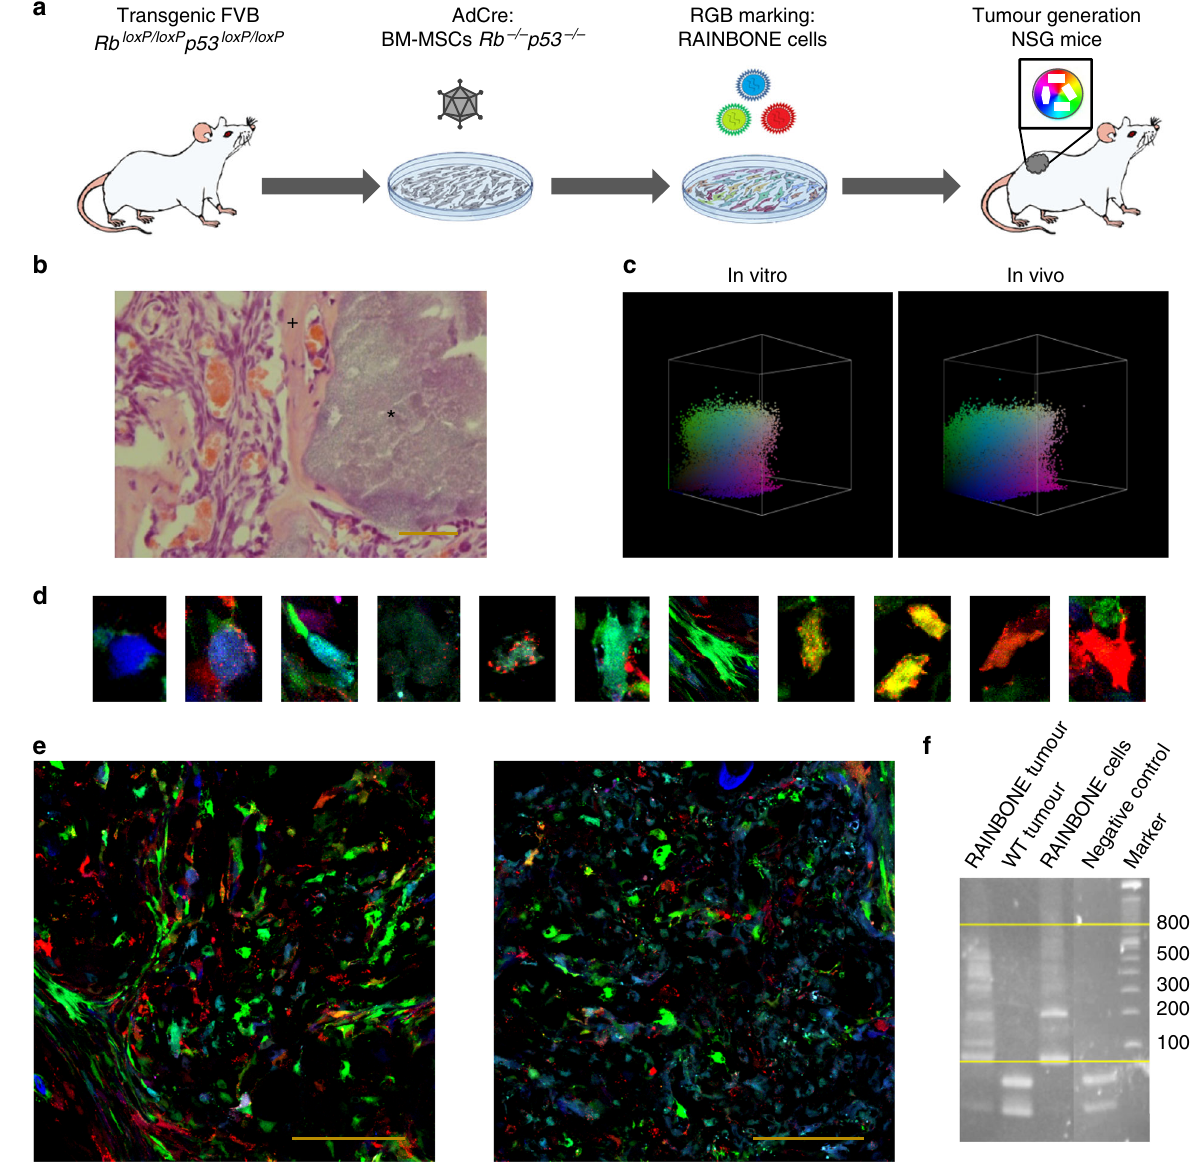
Fig. 2 RAINBONE cells generate polyclonal tumours in ectopic implants. a Experimental scheme employed for ectopic OS development ( n = 7). b Haematoxylin/eosin staining (HE) staining of tumours generated by ectopically implanted cells. Spindled cells produced abundant bone matrix ( + ) near HA/TCP ceramics (*). c Representative 3D fl ow cytometry analysis of in vitro RAINBONE cells (left) and explanted tumour cells at day 25 (right) ( n = 3). d Representative confocal images showing the colour spectra of different in vivo tumour clones. e Representative confocal macroscopic view of polyclonal RAINBONE tumours indicating the contribution of different clones to tumour generation; orange bars = 100 µ m. f LAM-PCR analysis showing the ampli fi cation of different provirus integration sites in RAINBONE tumours. Picture represents the same gel; vertical lines were added where non- informative lanes were excised. Horizontal yellow lines demarcate the standard size range of the PCR products to exclude ampli fi cation artefacts. Negative control = water, WT tumour = tumour generated by unmarked